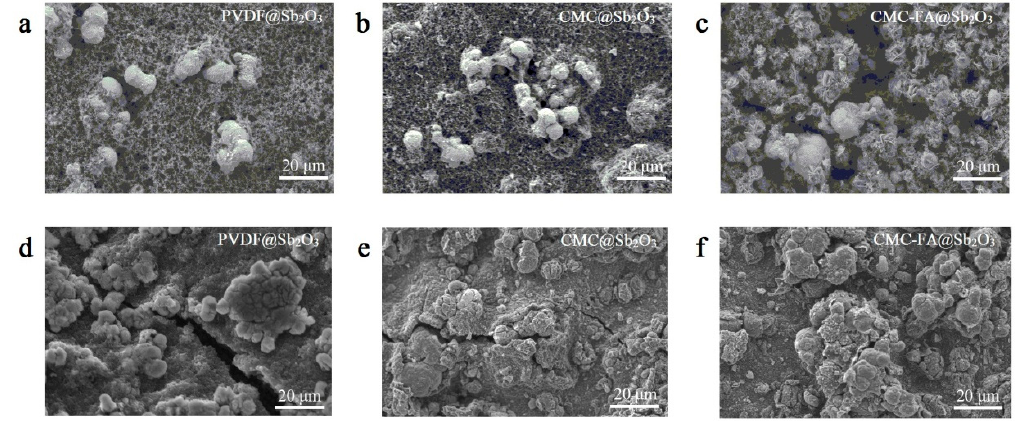
Figure 5. SEM images of electrodes before cycling: ( a ) PVDF@Sb 2 O 3 , ( b ) CMC@Sb 2 O 3 , ( c ) CMC- FA@Sb 2 O 3 ; SEM images of electrodes after 200 cycles at current density of 200 mAh g − 1 : ( d